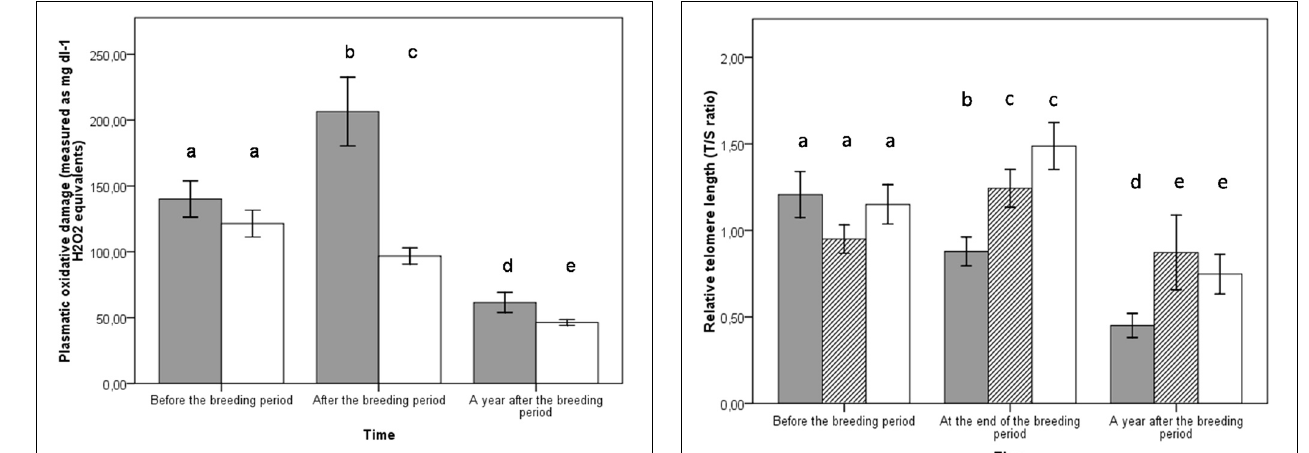
FIGURE 3 | Telomere lengths for both parents in the three different groups at different time periods: before the breeding event (enhanced group n = 18, control group n = 18, reduced group n = 14), at the end of the breeding event (enhanced group n = 18, control group n = 18, reduced group n = 14), a year after the breeding event (enhanced group n = 10, control group n = 6, reduced group n = 11). Bars represent ± SE. Enhanced in gray, control in hatched, reduced in white. Groups which are not significantly different from another are marked with the same letter.